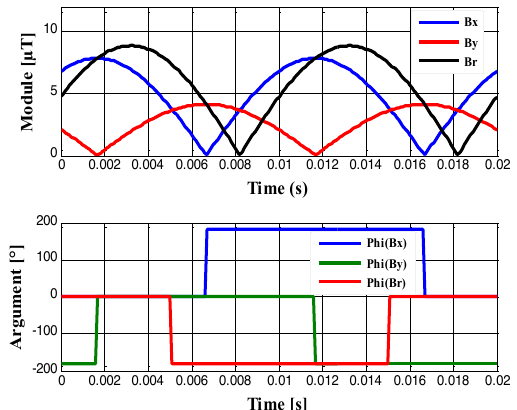
Figure 10: Temporal variation of the magnetic induction strength at mid-span at 1 m above the ground.